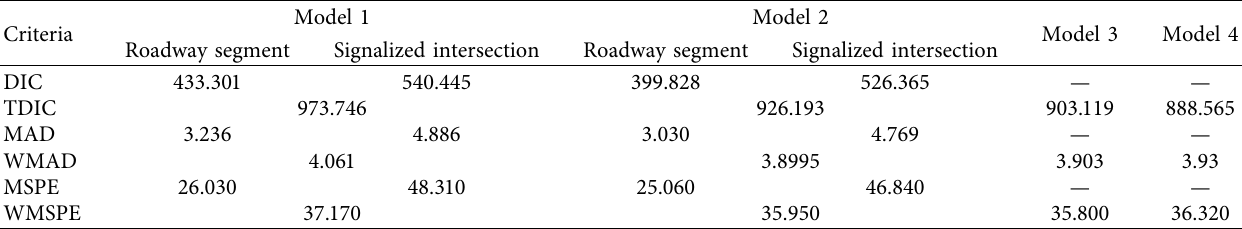
Table 4: Summarized results of the predictive performance for models 1–4.